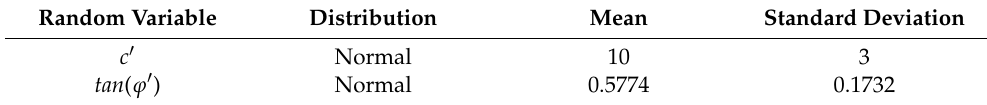
Table 2. The statistical parameters of random variables for infinite slope without pore pressure.